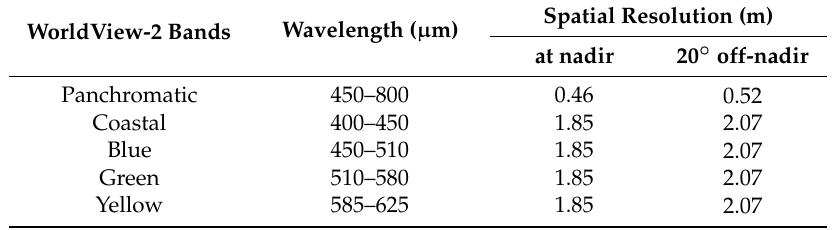
Table 2. Spectral characteristics and spatial resolution of the WorldView-2 spectral